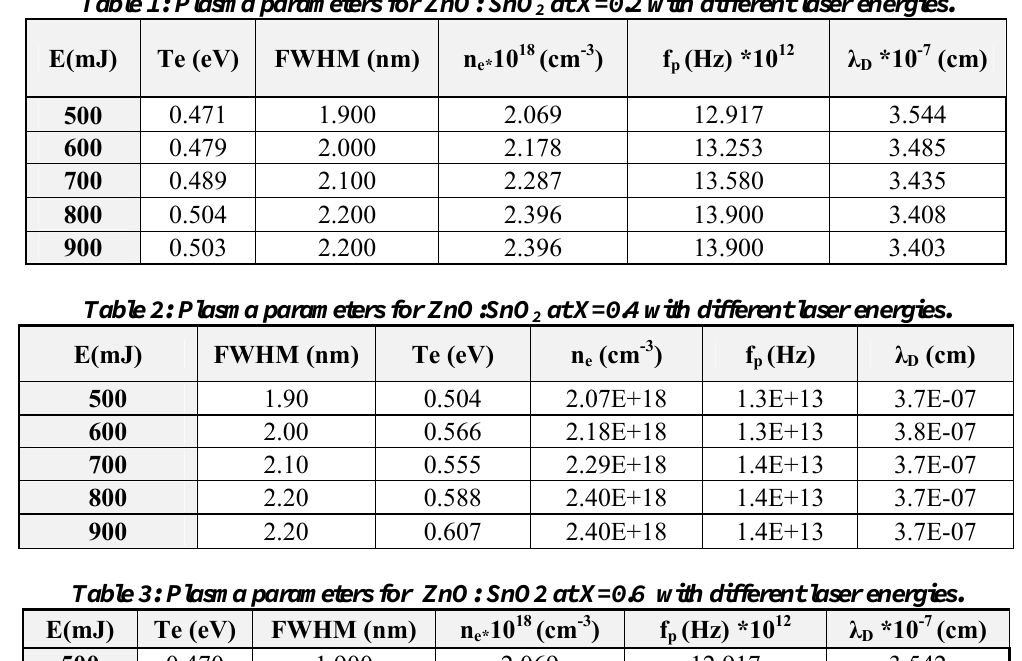
at X=0.2 with different laser energies. 2